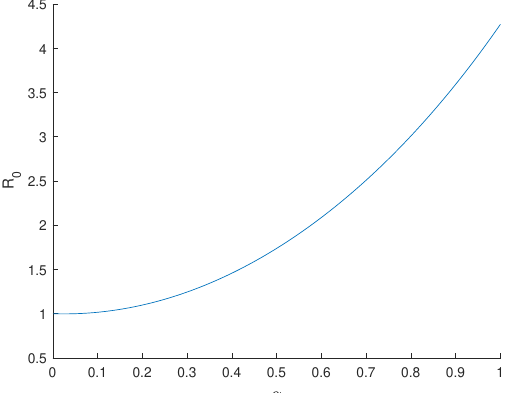
Figure 4. Impact of the variation of the derivative order, α , in the evolution of the basic reproduction number R 0 of the COVID-19 model (2).